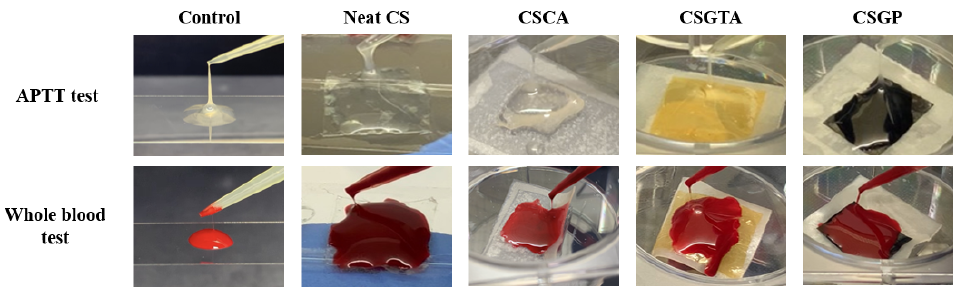
Figure 4. Clot-forming behaviors of the TB-CS films with canine whole blood.